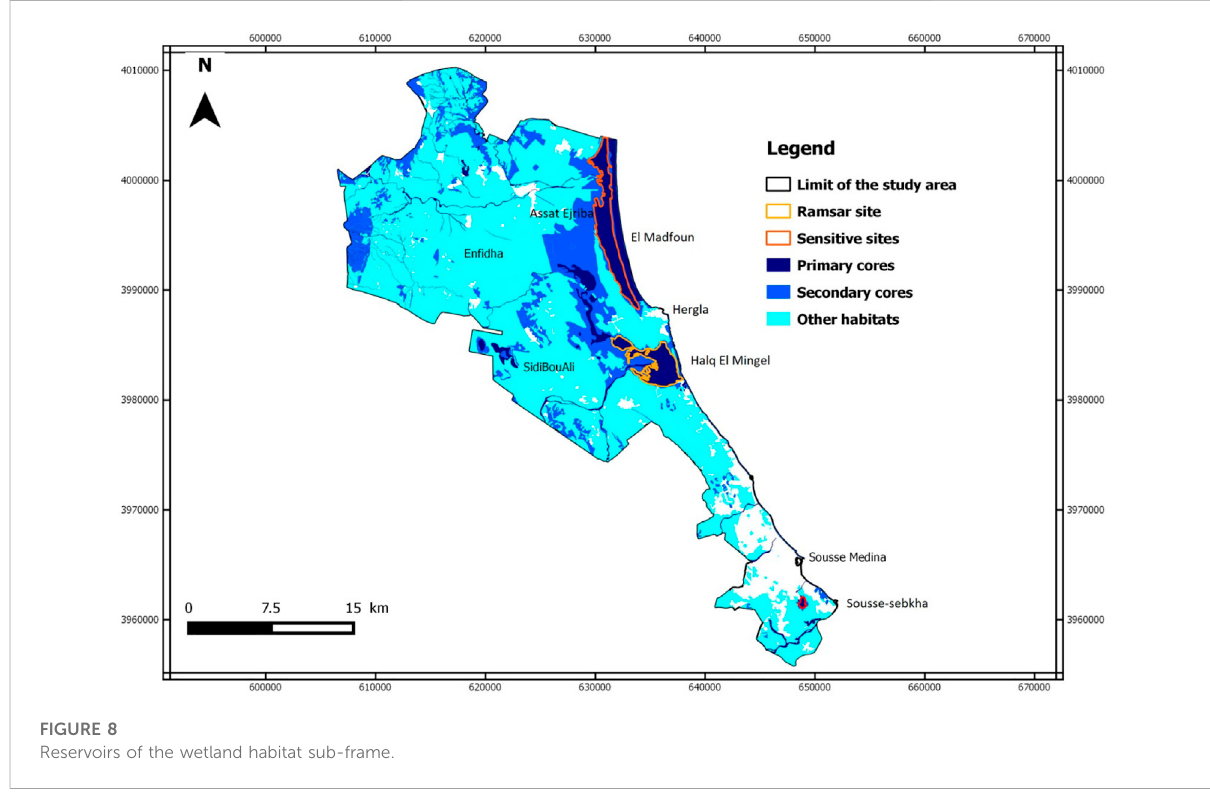
FIGURE 8 Reservoirs of the wetland habitat sub-frame.